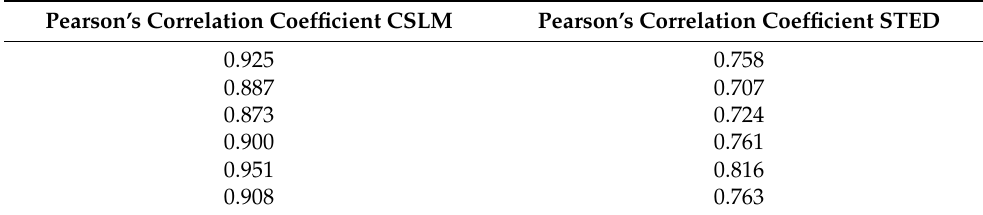
Table 3. Comparison of the Pearson’s correlation coefficient, as a measure for lamin A/C and B1 colocalization, found in CSLM and STED images of the same laminopathy dermal patient fibroblasts with an LMNA c.1130G>T (p.(Arg377Leu))